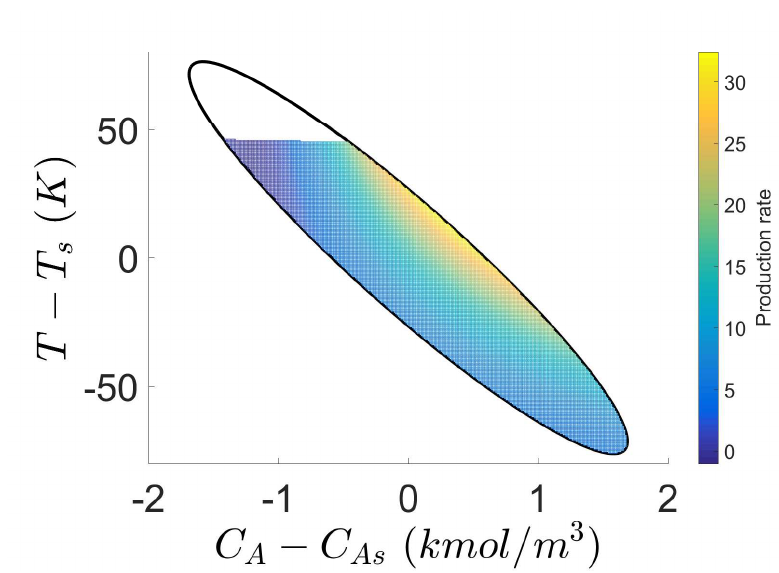
Figure 6. The production rate L e = k 0 e − E / RT C 2